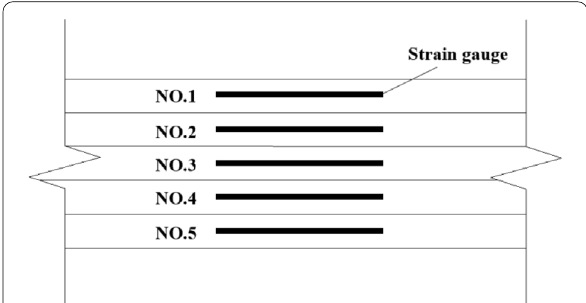
Fig. 14 The serial number of Strain gauges placement along the beam at the mid-span